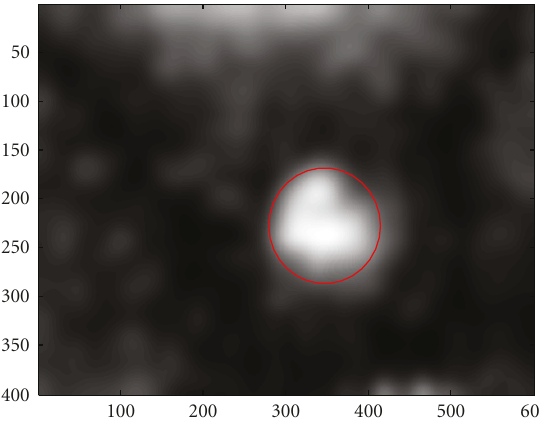
Figure 6: Segmentation using the conspicuity map.